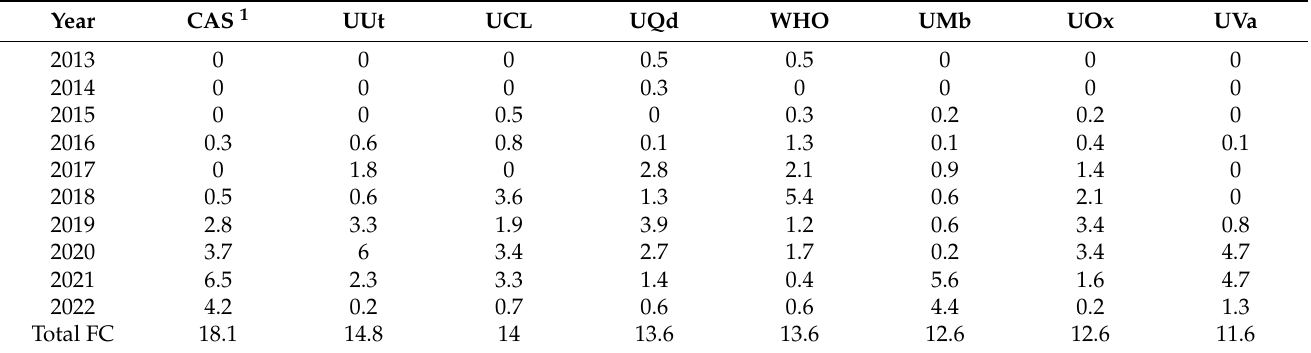
Table 4. The top eight institutes with the most FCs of publications from 2013 to